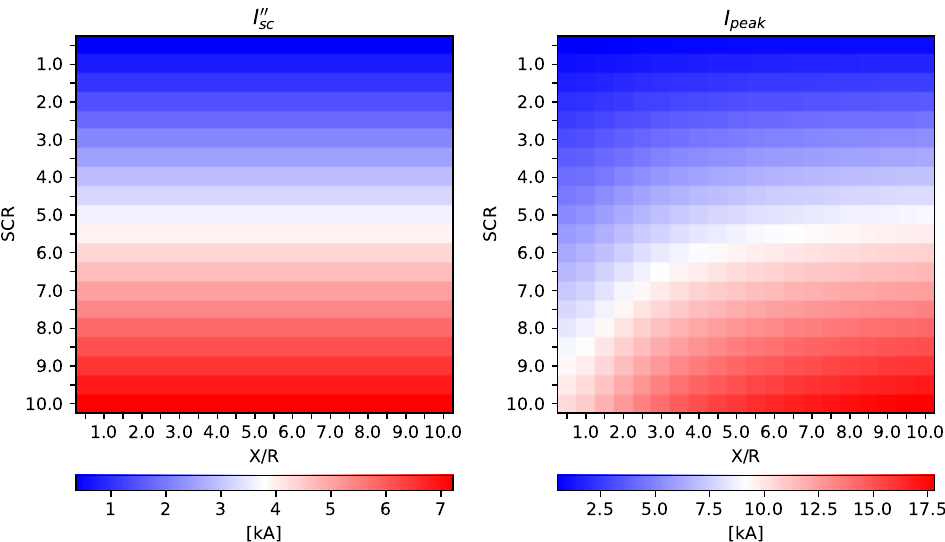
Figure 1. Short-circuit currents for various short-circuit ratios (SCR) and X / R ratios from a three- phase fault. Note that the initial symmetric short-circuit current is given by I (cid:48)(cid:48) sc = S (cid:48)(cid:48) sc / ( the peak short-circuit current is given by I peak = κ such that: κ = 1.02 + 0.98e − 3 R / X